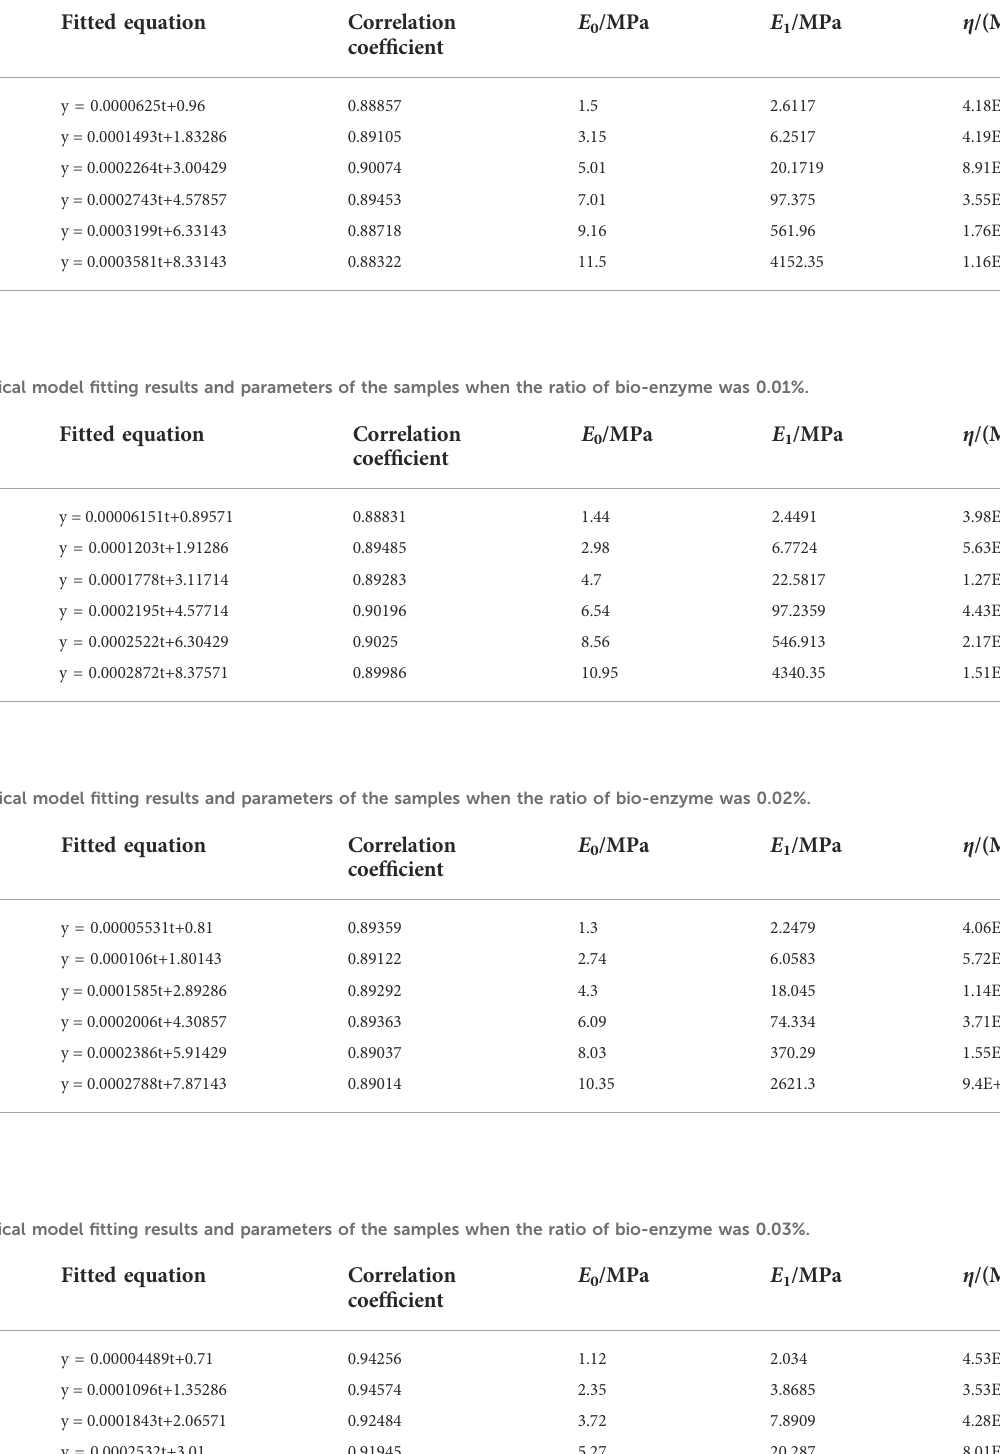
TABLE 2 Rheological model fi tting results and parameters of the samples when the ratio of bio-enzyme was 0.00%.